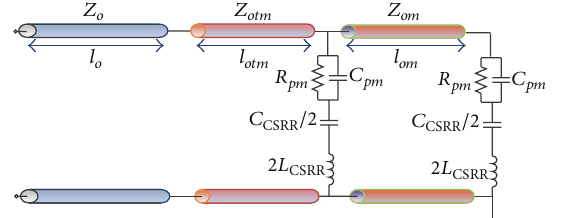
Figure 20: Circuit model of miniaturized patch loaded with CSRR using transmission lines.